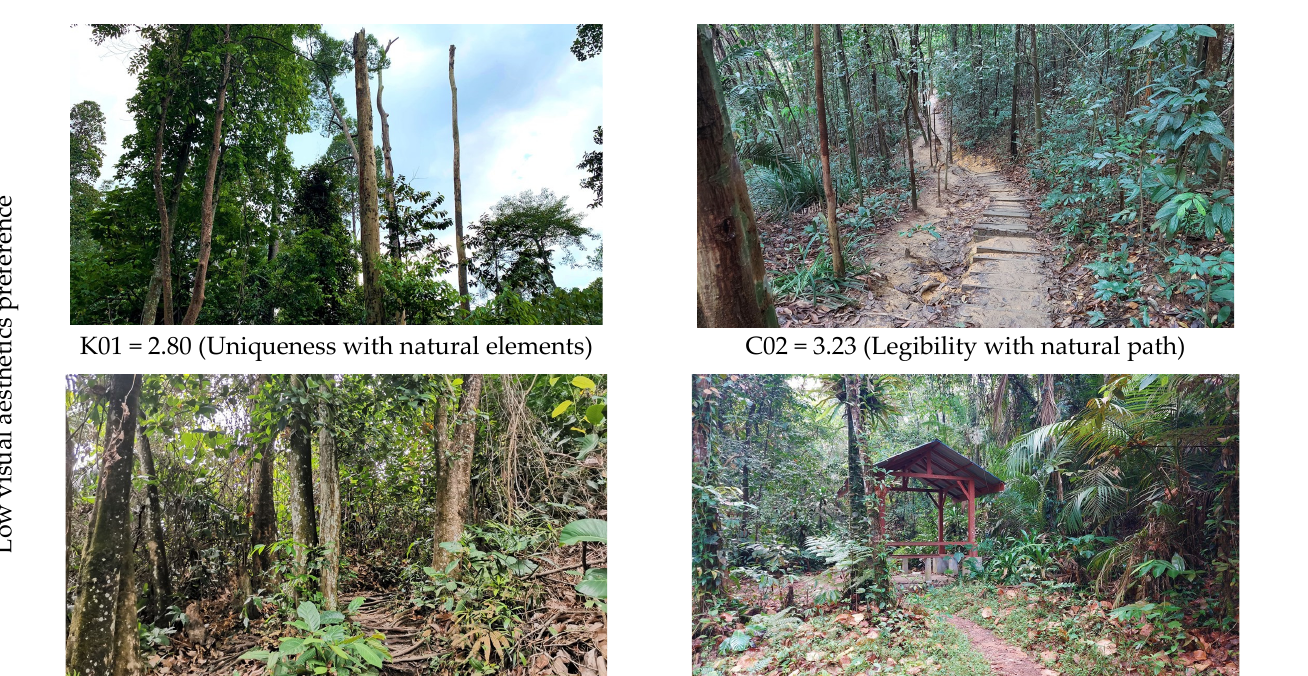
Figure 3. High- and low-preference photos of visual aesthetics based on the expert survey. To identify a linear sequence of the importance of the variables, the mean values for each variable were calculated. It was found that the four highest mean scores for the visual aesthetic variables based on the expert survey were I = 4.49 (openness with city view), M = 4.46 (uniqueness of water with natural elements), J = 4.36 (openness with a water view), and N = 4.34 (uniqueness of water with man-made elements). These findings are consistent with the results from the preferred individual photos. These results indicate that openness of the city viewed from the peak of the urban forest was preferred over all other